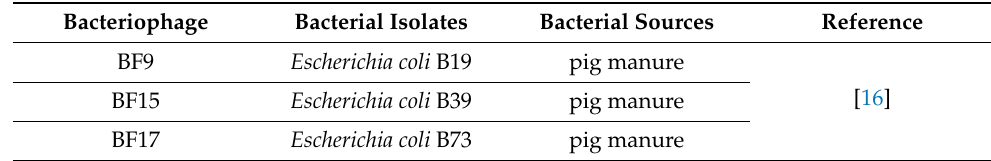
Table 1. Bacteriophages and bacteria used in the